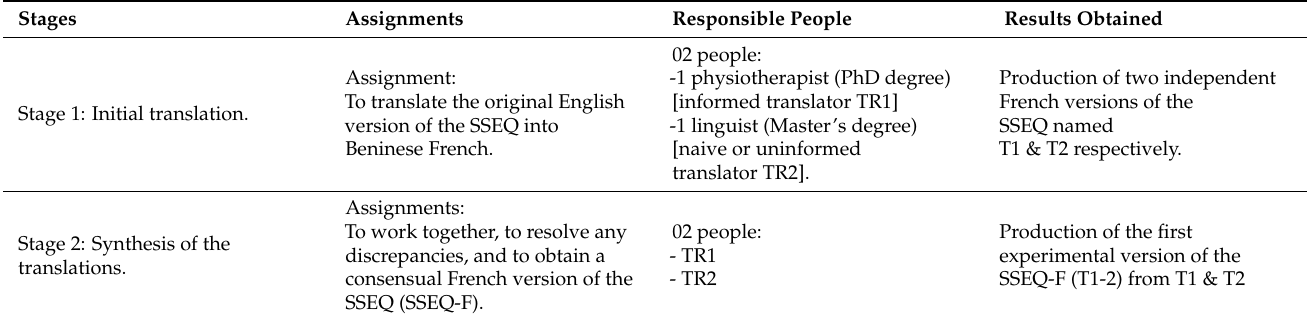
Table A1. Translation and adaptation process of SSEQ into